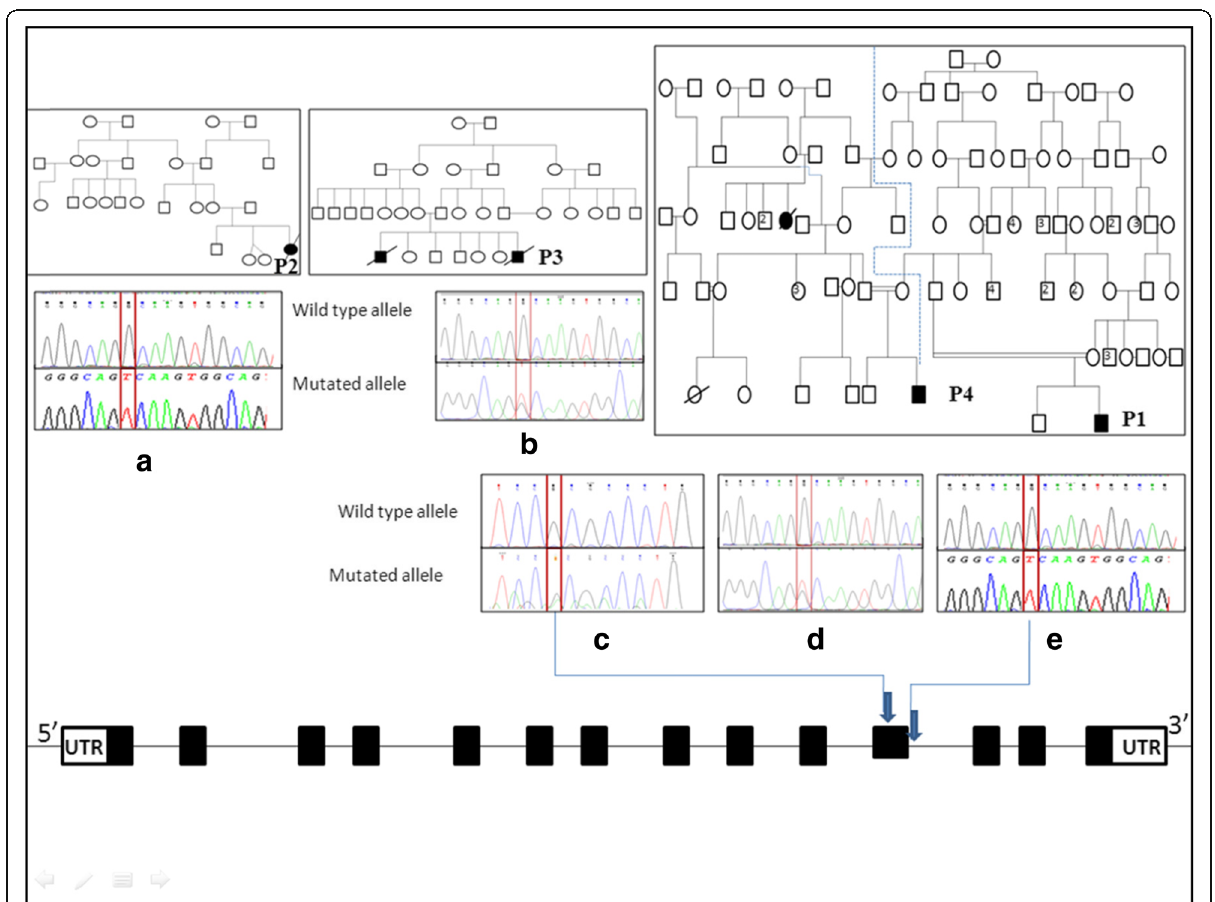
Fig. 2 Sequence electropherograms of the IDUA mutations identified in the patients with Hurler syndrome: a and e showing the homozygous c.1650 + 1G > T splice site mutation (P1 and P2). b and d showing the heterozygous c.1650 + 1G > T splice site mutation (P3 and P4). c showing the heterozygous p.R555H missense mutation